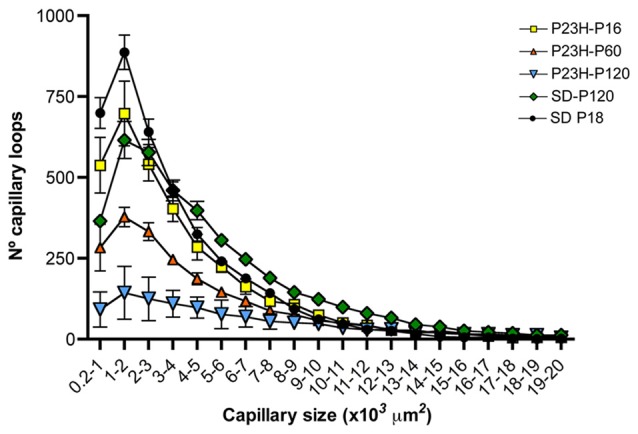
Relationship between capillary loop size and density in the DCP of P23H rats. Mean number of capillary loops for each of the 20 size ranges (from 200 μm2 to 20,000 μm2). Note that the relative loss of capillary loops in P23H rats was inversely proportional to their size.